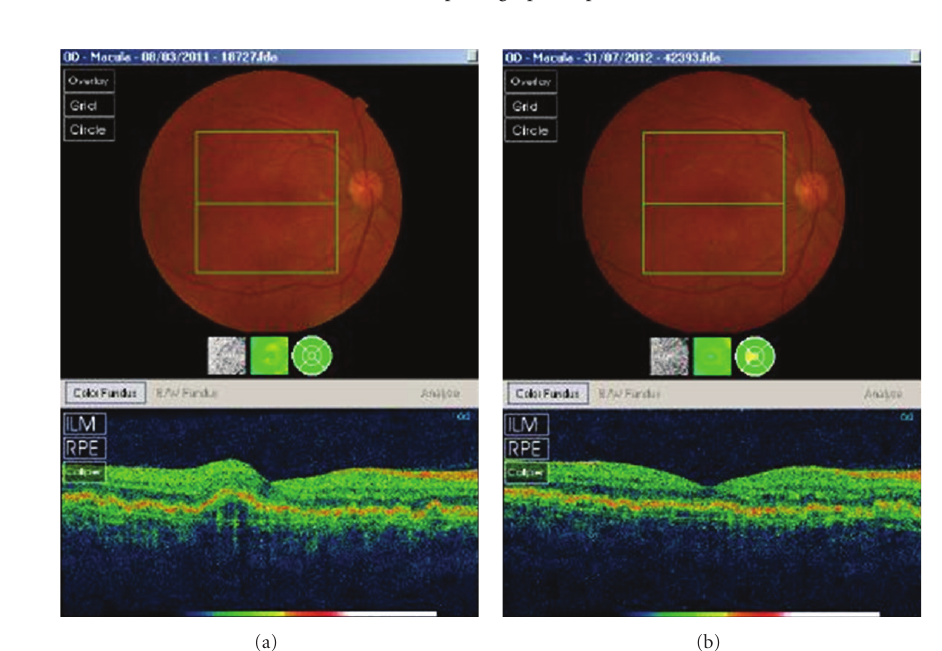
Figure 2: OCT images of the right eye at presentation (a) and 18 months later